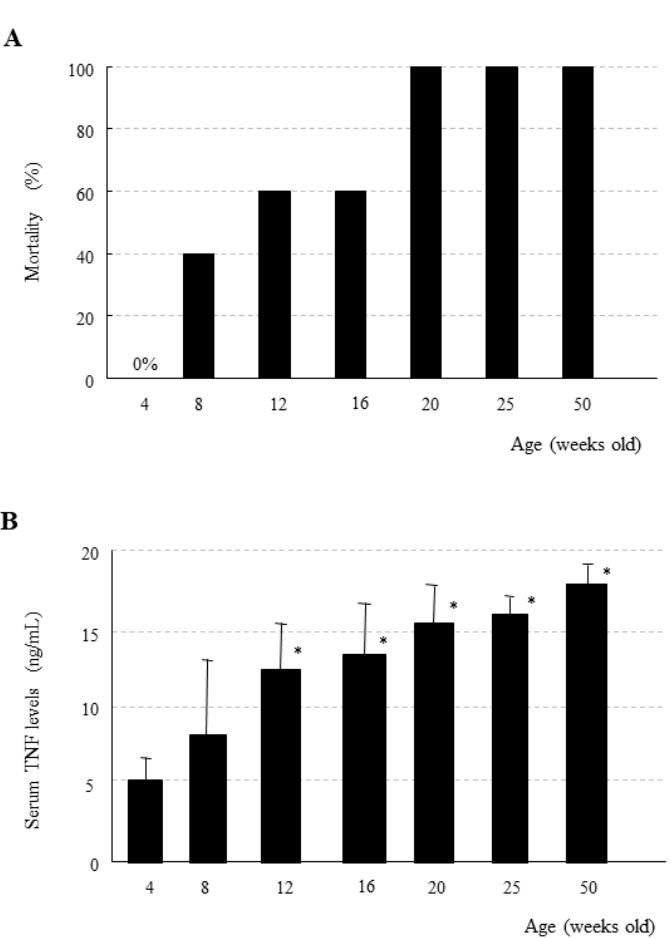
Figure 2. Age-dependent increase in mortality due to the generalized Shwartzman reaction accompanied by elevation of serum TNF. ( A ) Mortality due to the generalized Shwartzman reaction induced by IL-12 priming, and, subsequent LPS challenge was age-dependently increased in mice. ( B ) Serum TNF levels were also age-dependently increased at 1 h after LPS challenge following IL-12 priming. Data are mean ( A ) and means ± SE ( B ) from five mice in each age group. * p < 0.01 vs. four weeks old, using an analysis of variance with Scheffe’s F test. Figures are revised from [39].